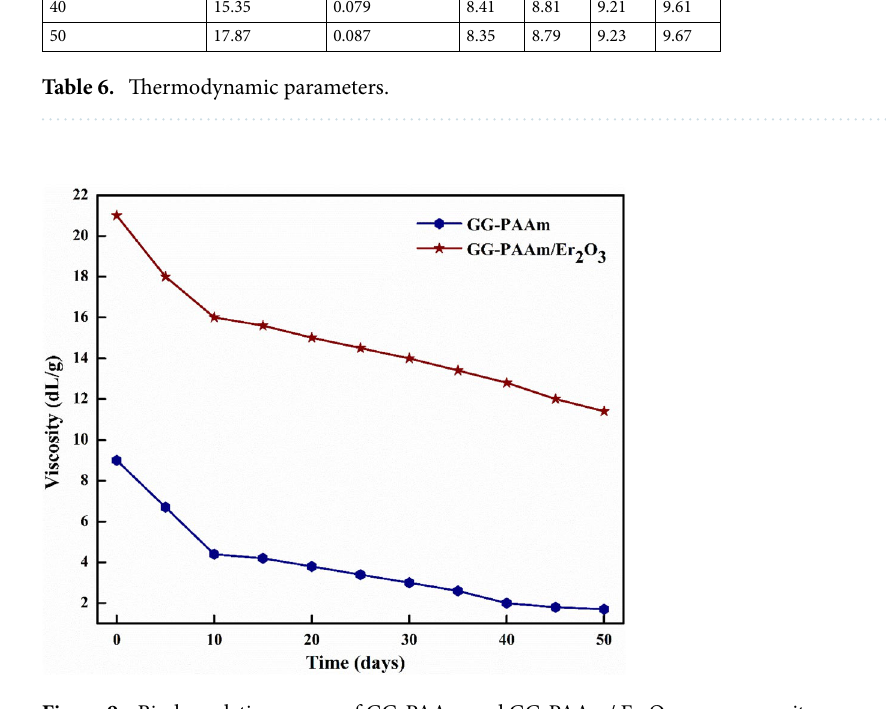
Figure 9. Biodegradation curves of GG-PAAm and GG-PAAm/ Er 2 O 3